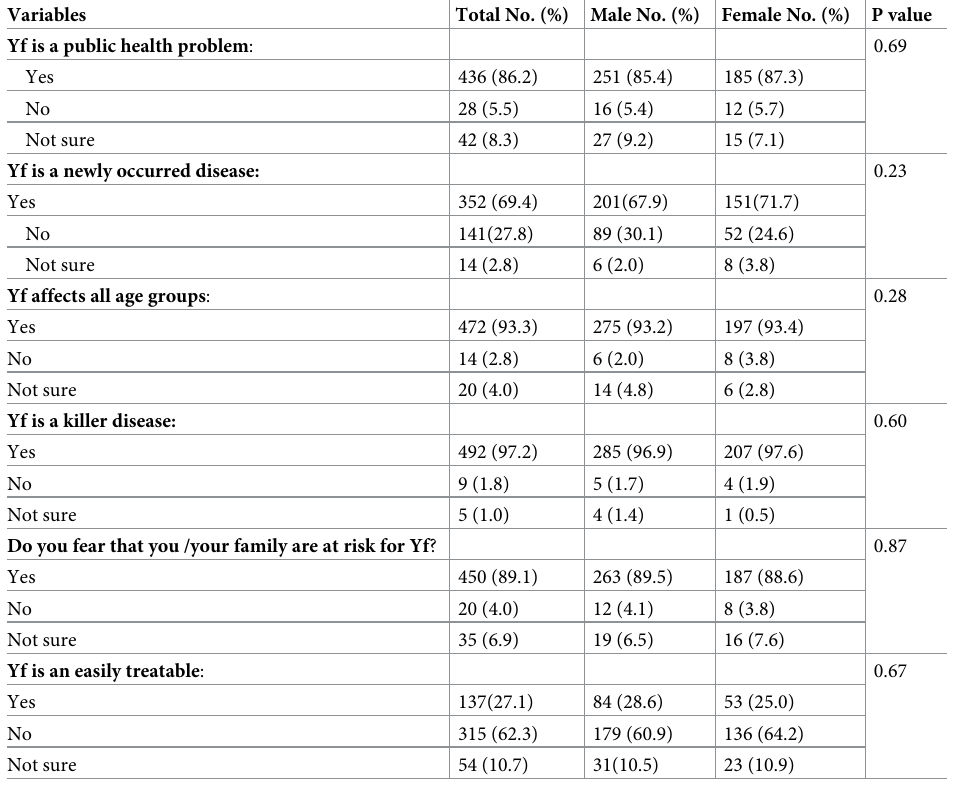
Table 5. Community’s attitudes regarding the public health importance of Yf.